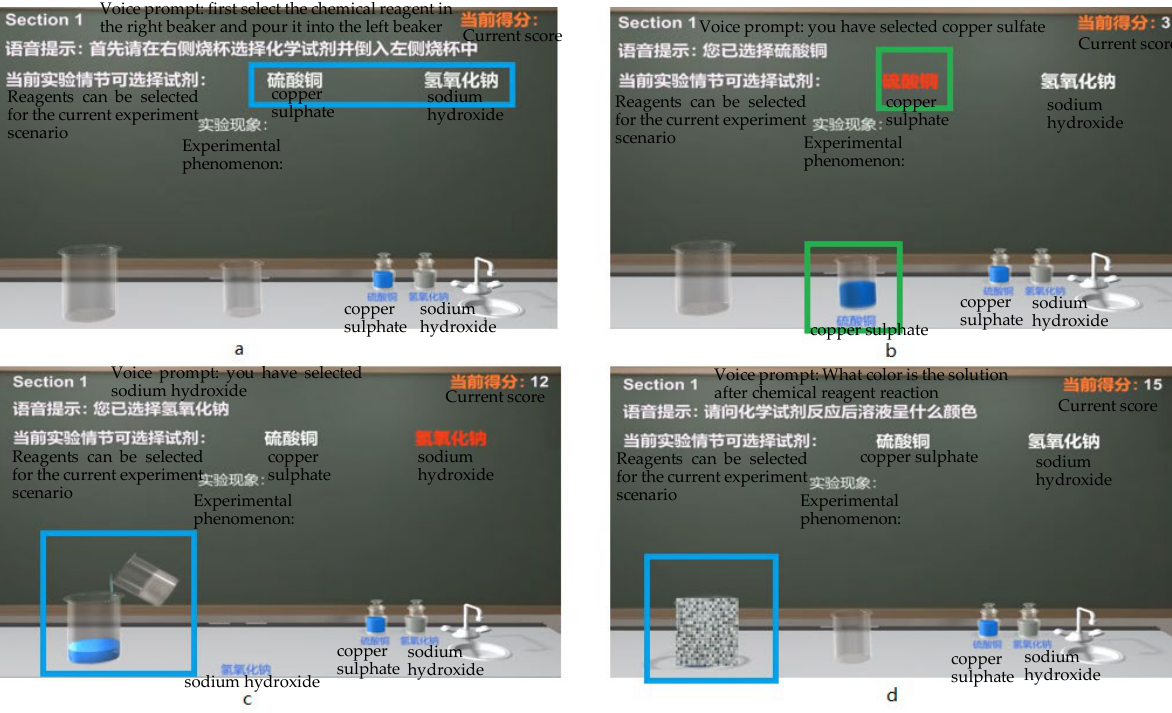
Figure 12. Copper sulfate reacts with sodium hydroxide solution 1. ( a ). Reagent selection interface 1. ( b ). Reagent selection interface 2. ( c ). Drug dumping interface. ( d ). Experimental